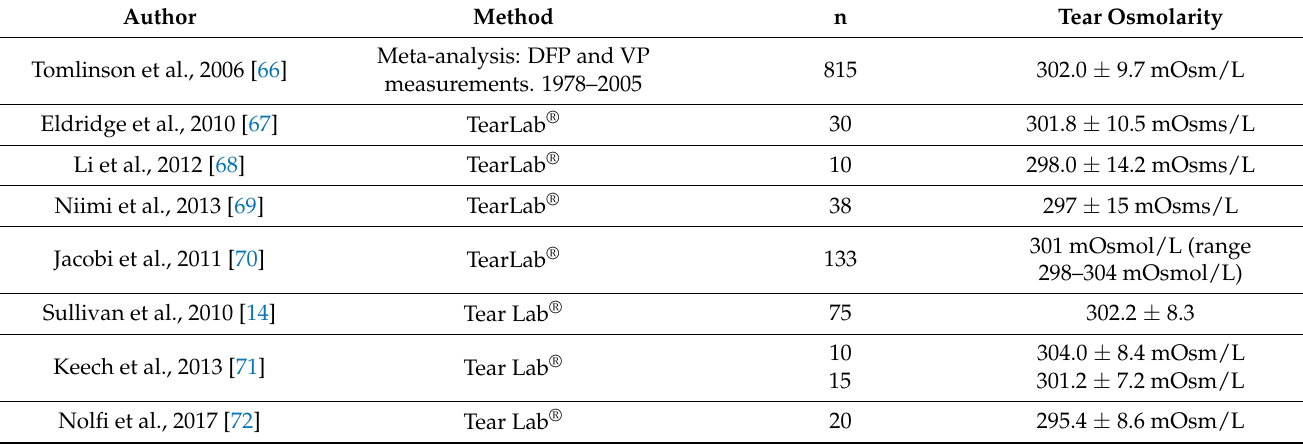
Table 1. Average tear osmolarity (tOsm) values for normal subjects, from the